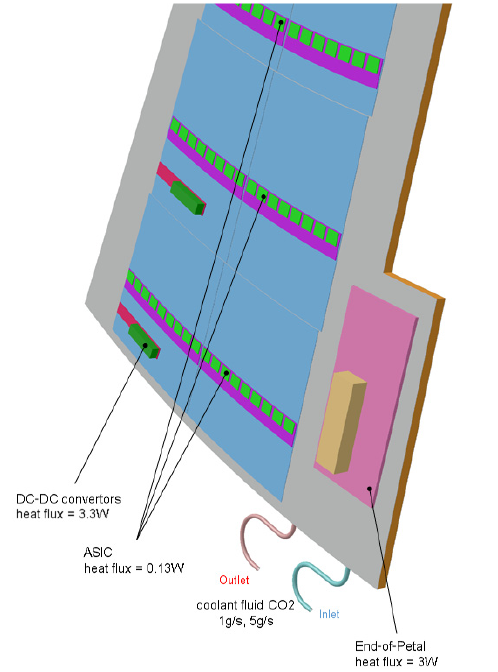
Figure 7. Boundary conditions and heat sources